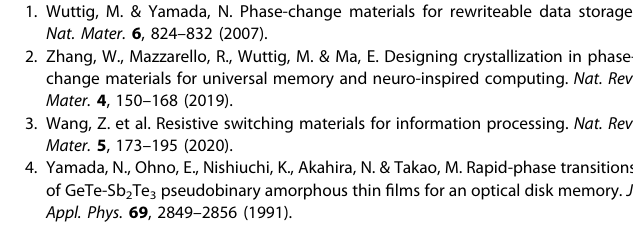
Fig. 1. Enhanced amorphous stability might be achieved, for instance, via doping with impurities like C or N 25 – 27 . For example, N atoms were shown to bond mostly with Ge atoms in amorphous Ge 2 Sb 2 Te 564 . This bonding pattern is expected to reduce the tendency of elemental Ge segregation. Alternatively, the amorphous-phase stability of Ge-rich GST alloys could potentially be enhanced by reducing the fi lm thickness to a few nanometers. Indeed, it was shown that elemental Sb, which normally crystal- lizes spontaneously at room temperature, could be stabilized in either melt-quenched 65 or as-deposited 66 amorphous forms for several tens of hours by reducing the system size to ~3 – 4 nm thin fi lms. This approach employs nanosized con fi nement effects brought about by the surrounding materials 67 , with no need